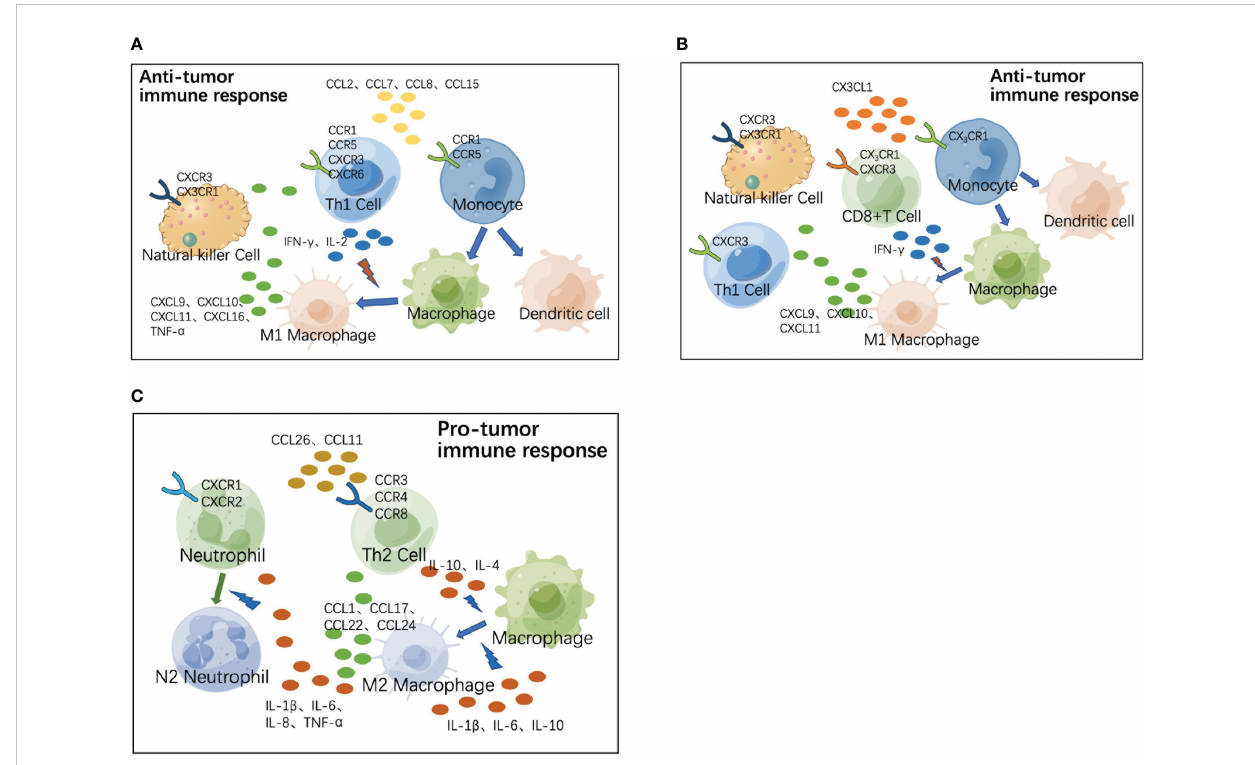
FIGURE 7 Role of chemokines and their receptors in co-localization of immune cells in tumor microenvironment (TME). (A) During the progression of colorectal cancer, CCR1 and CCR5 ligands (CCL2, CCL7, CCL8, CCL15, and so on) recruit monocytes and Th1 cells to the TME, where monocytes are precursors of macrophages and dendritic cells (DCs) and play the role of antigen presentation. Th1 produces IFN- g and IL-2, and IFN- g induces M1 polarization of macrophages. M1 macrophages exhibit enhanced antigen-presenting activity, while secreting CXCR3 ligands (CXCL9, CXCL10, CXCL11, and CXCL16) to recruit Th1 and natural killer (NK) cells and secrete TNF- a ; synergistically exerting anti-tumor functions. (B) In the early stages of colorectal cancer, the CX3CR1 ligand (CX3CL1) recruits NK cells, monocytes, and activated T cells to the TME. Monocytes differentiate into macrophages and DCs to play the role of antigen presentation. Activated T cells secrete IFN- g , upregulating the expression of CXCR3 ligands (CXCL9, CXCL10, and CXCL11) and recruiting Th1 and NK cells to perform anti-tumor functions. (C) During tumor progression, Th2 cells are recruited to the TME by CCR3 ligands (CCL26, CCL11, and so on), and produce IL-4 and IL-10, which induce M2 polarization of macrophages. M2 macrophages secrete CCL1, CCL17, CCL22, CCL24, and so on to recruit Th2 cells, as well as secreting in fl ammatory cytokines (IL-1 b , IL-6, IL-10, and so on) to continuously induce M2 polarization of macrophages. M2 macrophages secrete in fl ammatory cytokines (TNF-a, IL-1 b , and so on) to directly recruit neutrophils, while in fl ammation enhances endothelial adhesion and migration of neutrophils. In fl ammatory cytokines (IL-8, IL-6, and so on) in TME can induce M2 polarization of neutrophil cells; synergistically exerting pro-tumor